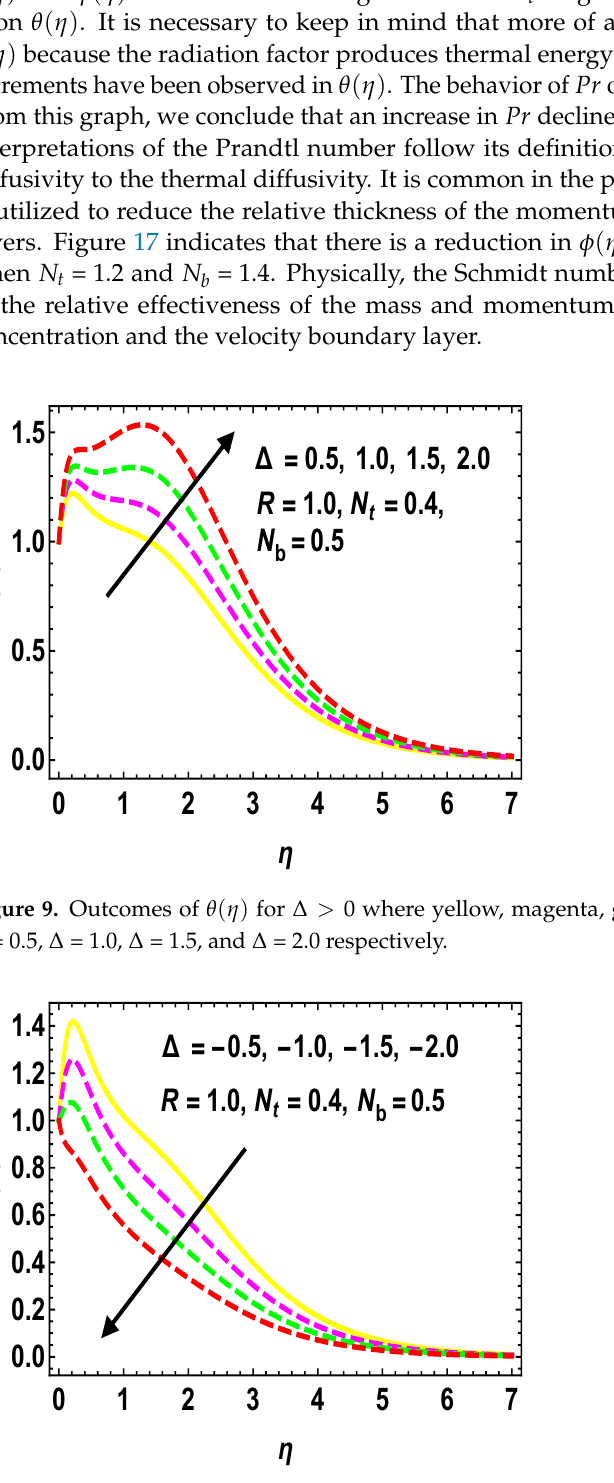
Figure 10. Outcomes of θ ( η ) for ∆ < 0 where yellow, magenta, green, and red lines represent for ∆ = − 0.5, ∆ = − 1.0, ∆ = − 1.5, and ∆ = − 2.0